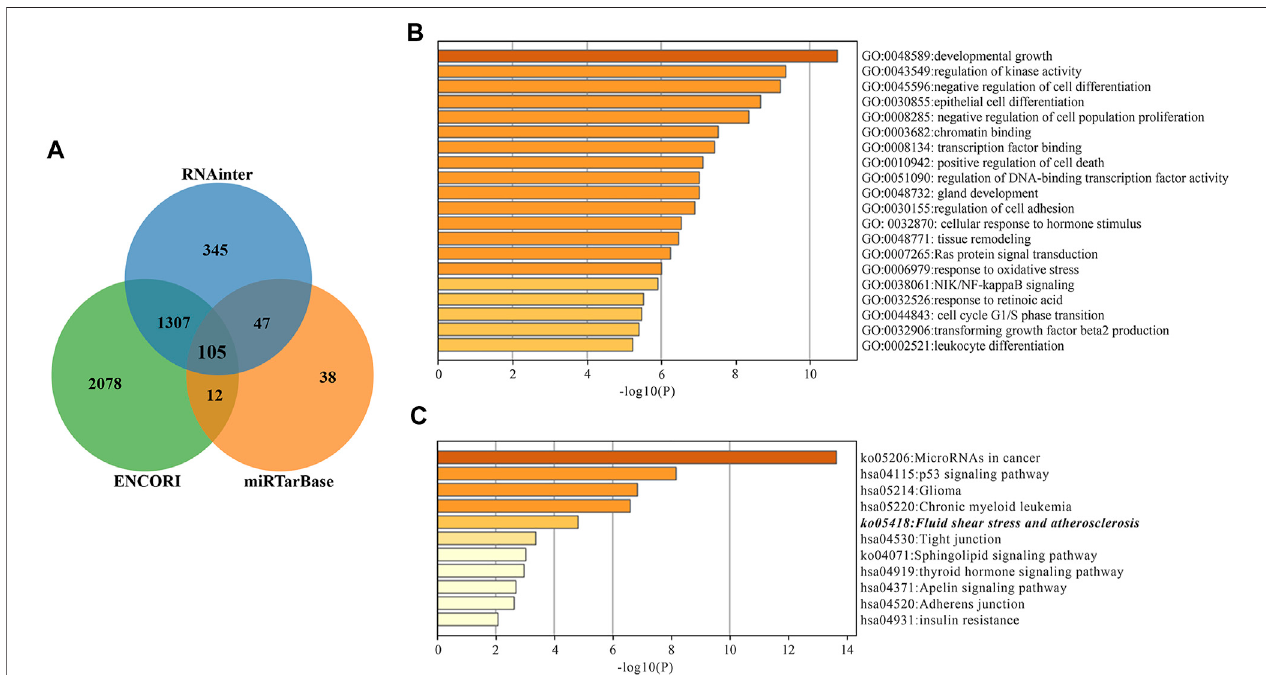
FIGURE 3 | miR-200a-3p target gene prediction and enrichment analysis. (A) Wayne diagram of miR-200a-3p target genes predicted by miRTarBase, RNAinter and ENCORI databases. (B) Target genes GO Biological Processes of miR-200a-3p. (C) miR-200a-3p Target genes KEGG Pathway Analysis. The “ Fluid shear stress and atherosclerosis ” pathway is